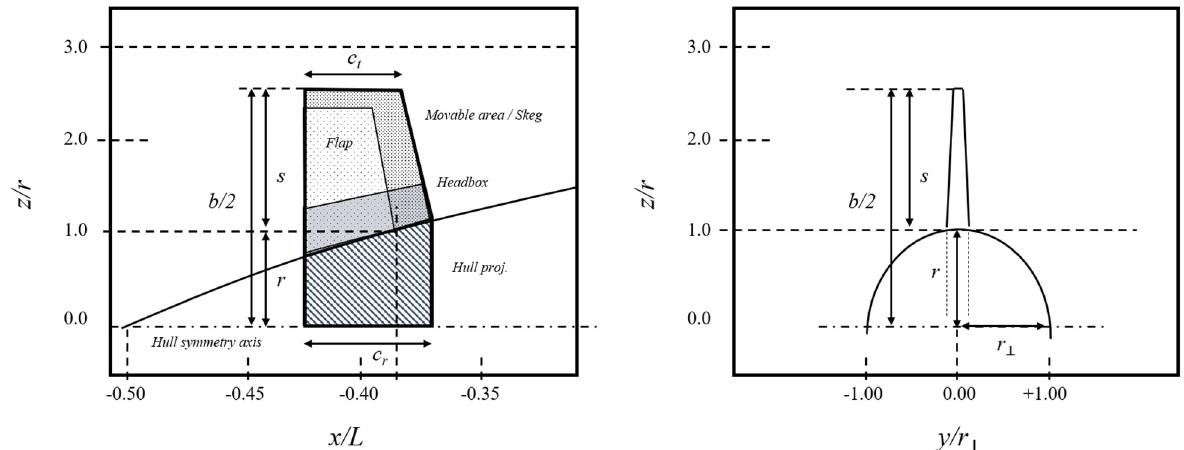
Figure 3. Control surfaces geometry.